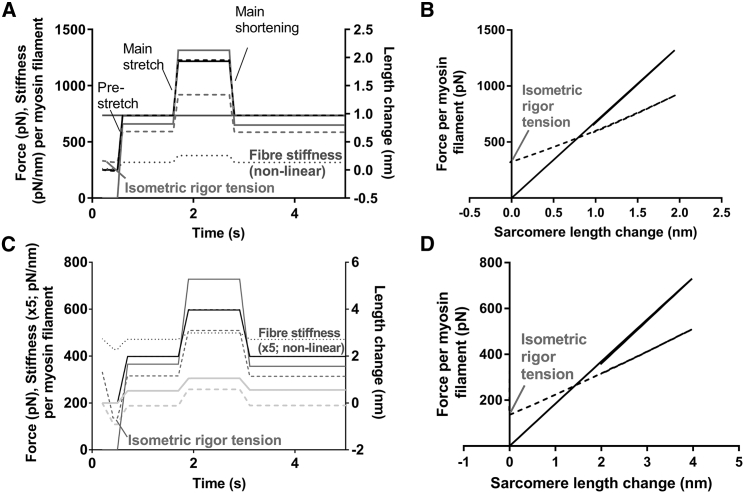
Model predictions for force and stiffness changes upon sequence of stretch-stretch-shortening ramps. (A) Time courses with all compliance assumed to reside in cross-bridges. Full lines: linear cross-bridge elasticity. Dashed/dotted lines: nonlinear cross-bridge elasticity. Black: sarcomere length (right vertical axis). Gray full and dashed lines: force (left axis). Gray, dotted lines: stiffness (left axis). Terminology: “prestretch,” “main stretch,” and “main shortening” used regularly in the text. Note nonzero force (“isometric rigor tension”) before any applied length change in the case with nonlinear cross-bridge elasticity. (B) Force-sarcomere-length relationships for data in (A). Full lines: linear cross-bridge elasticity. Dashed lines: nonlinear cross-bridge elasticity. (C) Time courses with 30 and 70% of sarcomere compliance assumed to reside in cross-bridges and myofilaments, respectively. Full lines: linear cross-bridge elasticity. Dashed/dotted lines: nonlinear cross-bridge elasticity. Black: sarcomere length (right vertical axis). Light gray: average length change of cross-bridges (right vertical axis). Dark gray full and dashed lines: force (left axis). Dotted gray line: sarcomere stiffness (×5) with nonlinear cross-bridge elasticity (left axis). Sarcomere stiffness for linear cross-bridge elasticity is constant and not shown. Note the lower magnitude of the average cross-bridge stiffness with nonlinear compared with linear cross-bridge elasticity. Note also that nonzero force is observed before any applied length changes in the case with nonlinear cross-bridge elasticity. (D) Force-sarcomere-length relationships for the data in (C). Full lines: linear cross-bridge elasticity. Dashed lines: nonlinear cross-bridge elasticity. Conversion: 200 pN corresponds to 100 kPa for a muscle cell. The average force or stiffness per cross-bridge can be obtained by dividing the values in the figure with 294 (see Materials and Methods).